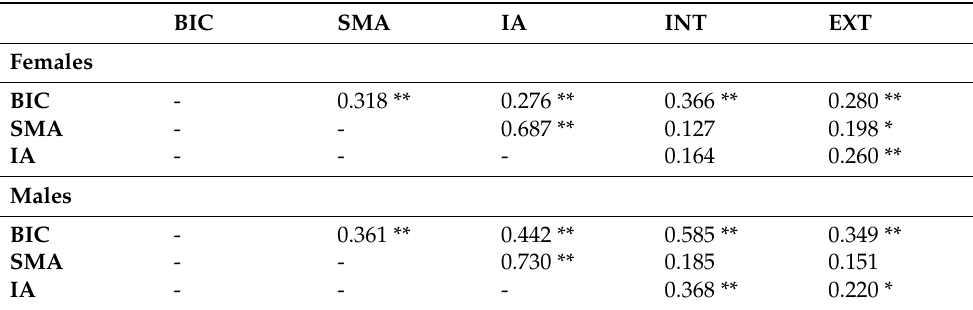
Table 3. Bivariate correlations among gender-related variables of interest.